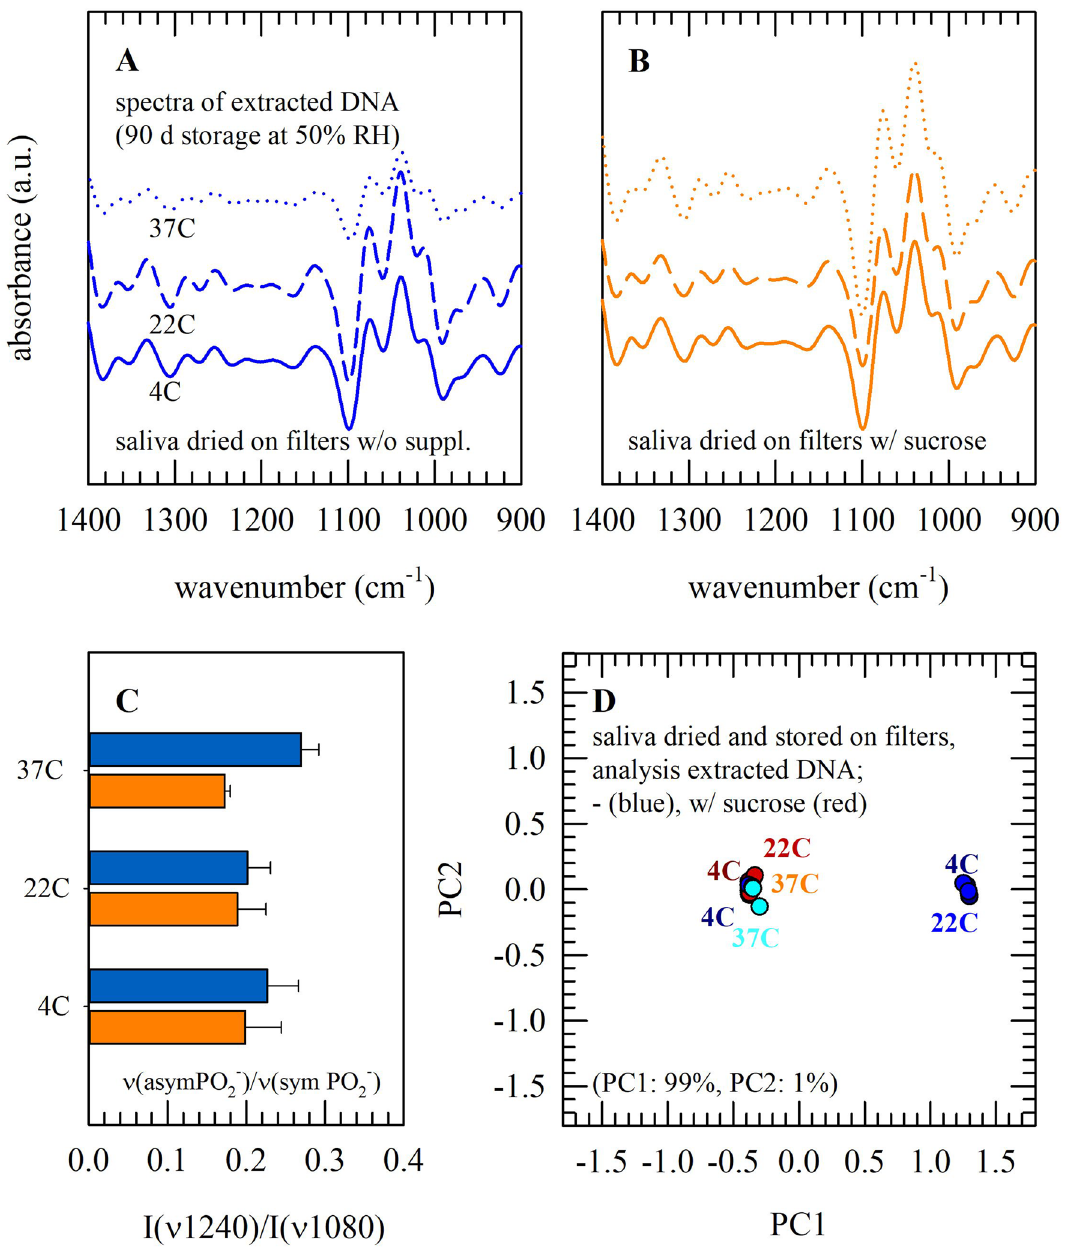
Figure 6. FT-IR spectral analysis of DNA extracted/recovered from saliva dried and stored on filters. Saliva was dried on filters without supplements (blue lines, bars and symbols) or with 10% sucrose (orange/red lines, bars and symbols), and stored for 90 d at different temperatures (4, 22, and 37 °C). Normalized second derivative spectra of the fingerprint spectral region are presented ( A , B ), as well as a comparison of the band intensity ratios of the asymmetric versus symmetric PO2- stretching vibration [ C ; I(v1240)/I(v1080)]. Furthermore, the 1400 − 900 cm −1 spectral region was subjected to PCA and score plots of the first two principal components were prepared ( D ; with lighter colors for higher temperatures). Pooled saliva was used from three different donors. Measurements were performed in triplicate, and mean values ± standard deviations are